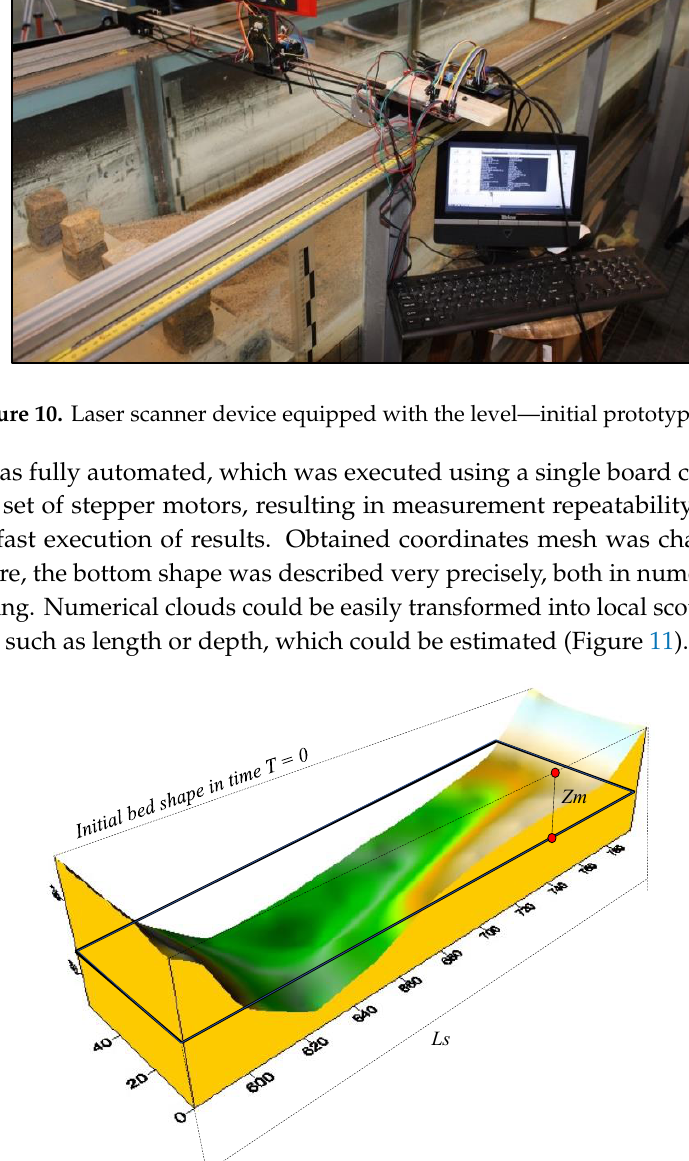
Figure 9. Laser scanner device on the steering wheels—prototype A2.